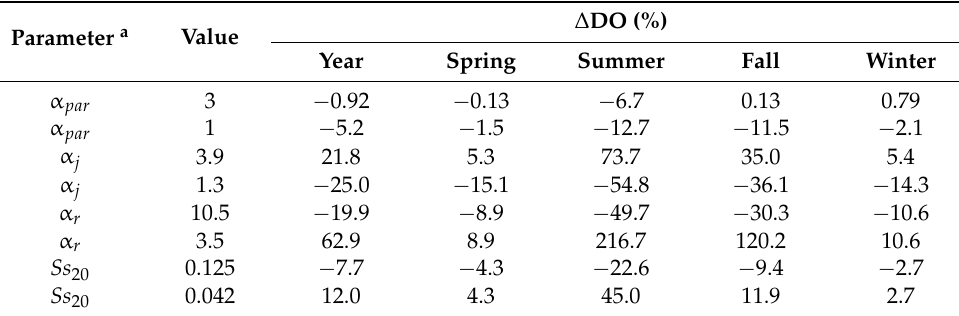
Figure 2. Hourly simulation of dissolved oxygen concentration in model calibration for ( A ) spring; ( B ) summer (dashed line on x -axis means discontinuous time); ( C ) fall; and ( D ) winter. Table 3. Results for sensitivity analysis.